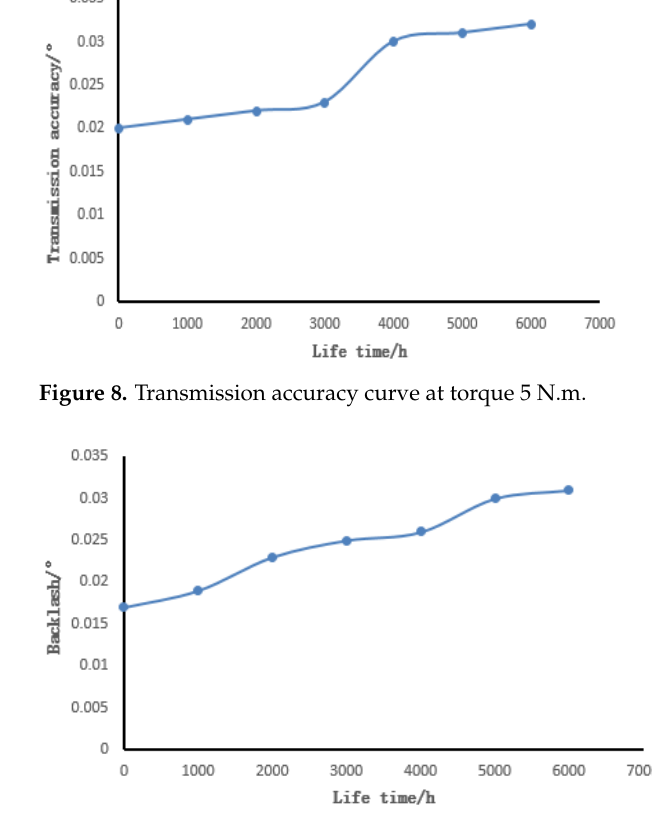
Figure 7. Efficiency test curve at torque 5 N.m.